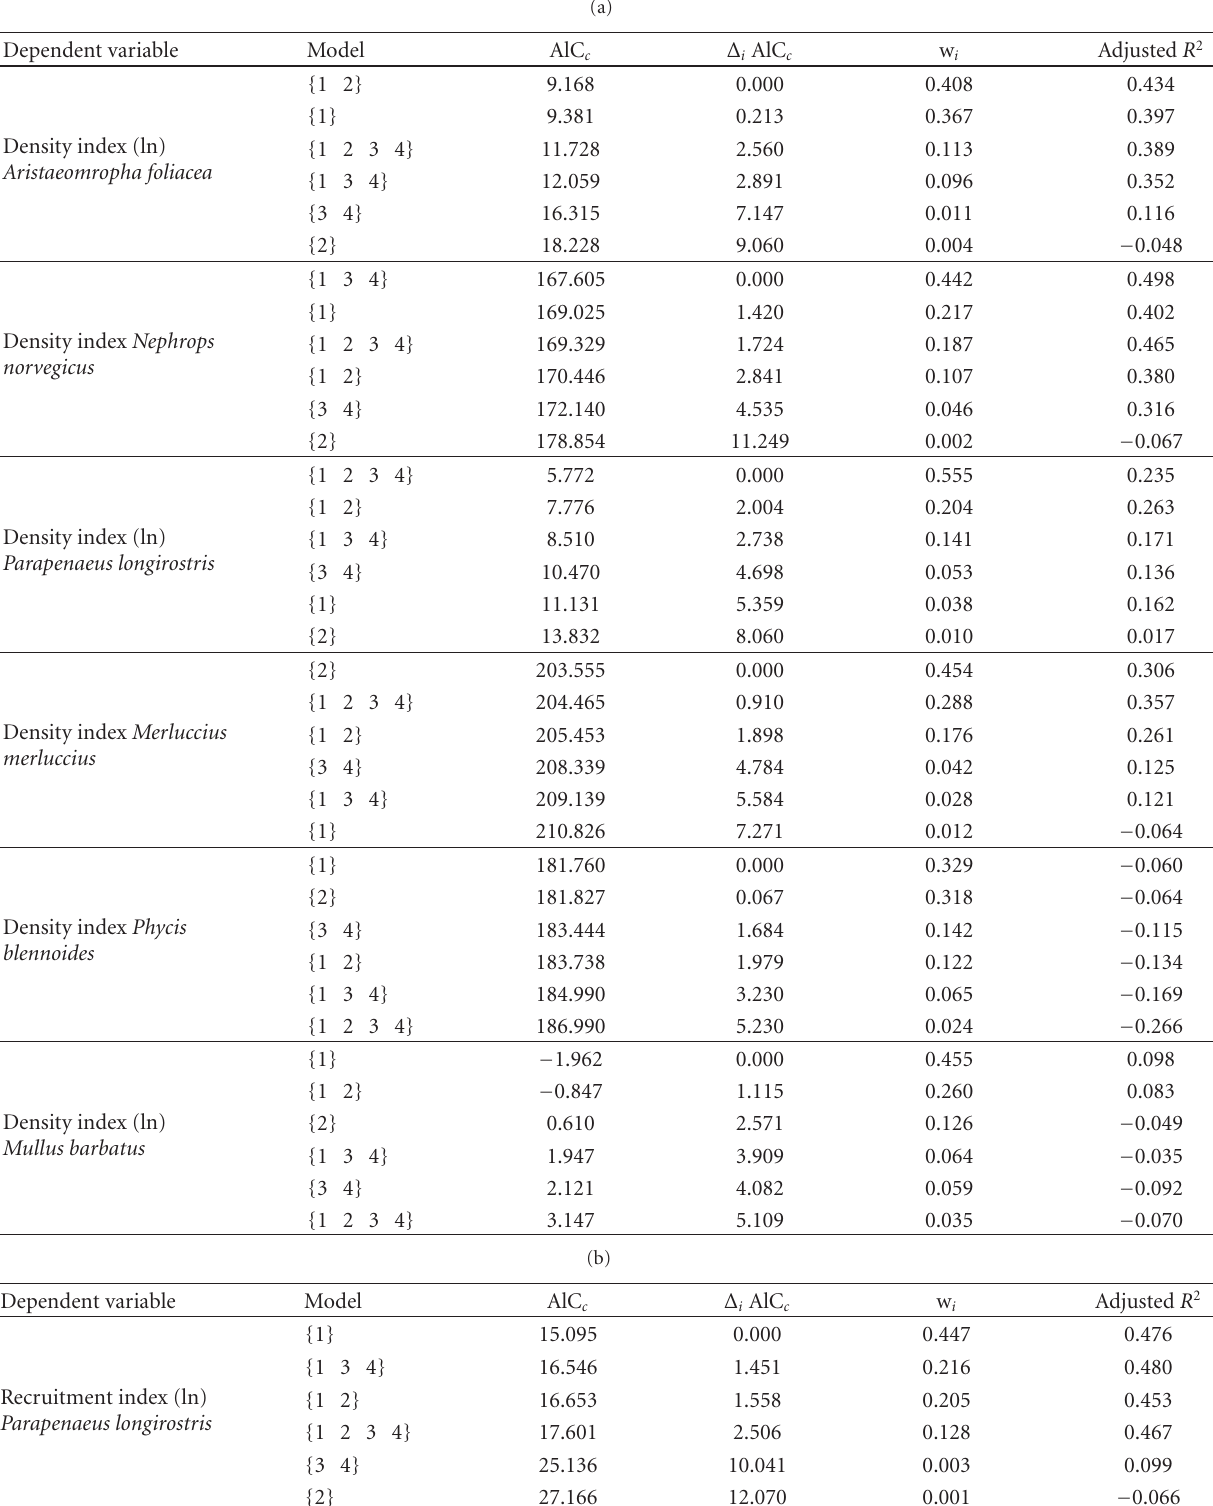
Table 2: (a) Summary of the six candidate models for density data of the species investigated in the Ionian Sea, including AIC c , Δ i values for AIC c , Akaike weights ( w i ), based on AIC c , and adjusted R 2 values. Models are ordered in terms of Δ i for AIC c . Predictive variables are: 1: fishing e ff ort, 2: NAO index, 3: SST and 4: precipitation. (b) Summary of the six candidate models for recruitment index of the species investigated in the Ionian Sea, including AIC c , Δ i values for AIC c , Akaike weights ( w i ), based on AIC c , and adjusted R 2 values. Models are ordered in terms of Δ i for AIC c . Predictive variables are: 1: fishing e ff ort, 2: NAO index, 3: SST and 4: